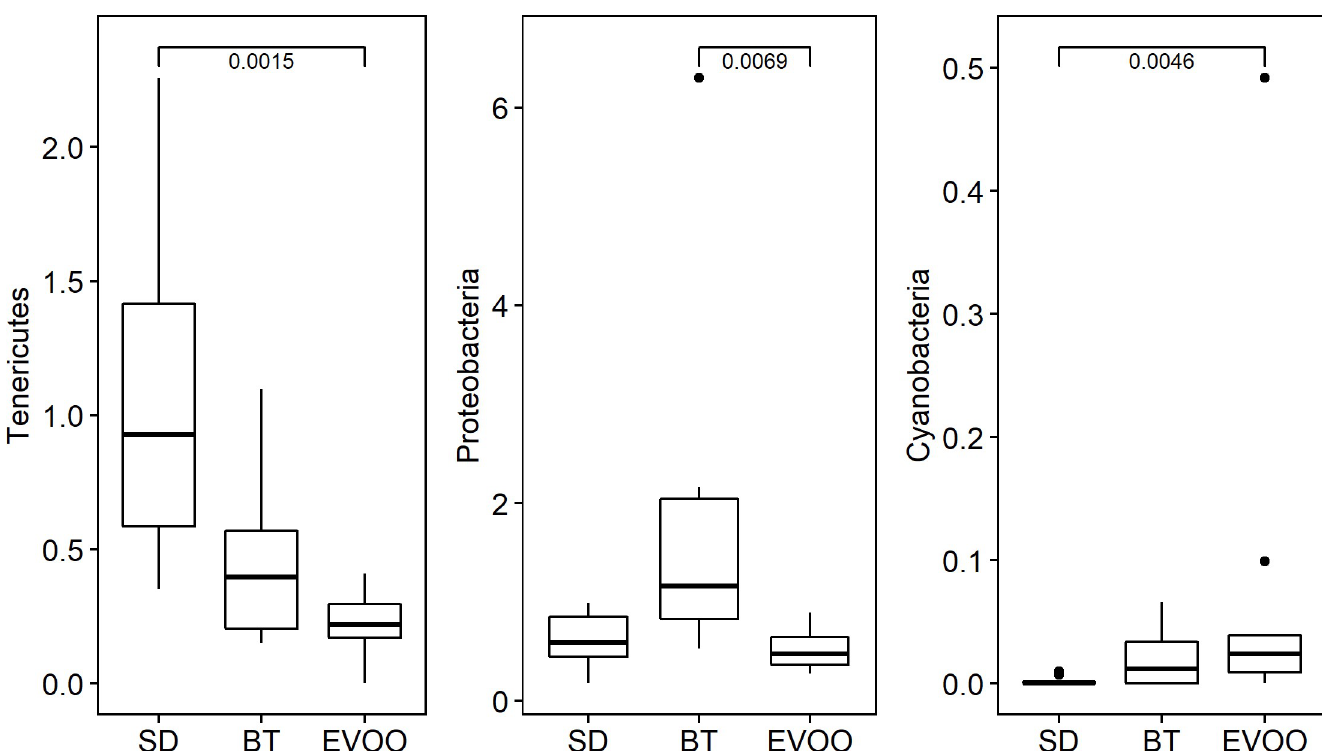
Fig 2. Box-plot representation of the percentage distribution of phyla Tenericutes , Proteobacteria and Cyanobacteria in mice fed a diet enriched with butter (BT), virgin olive oil (EVOO) or standard chow (SD).